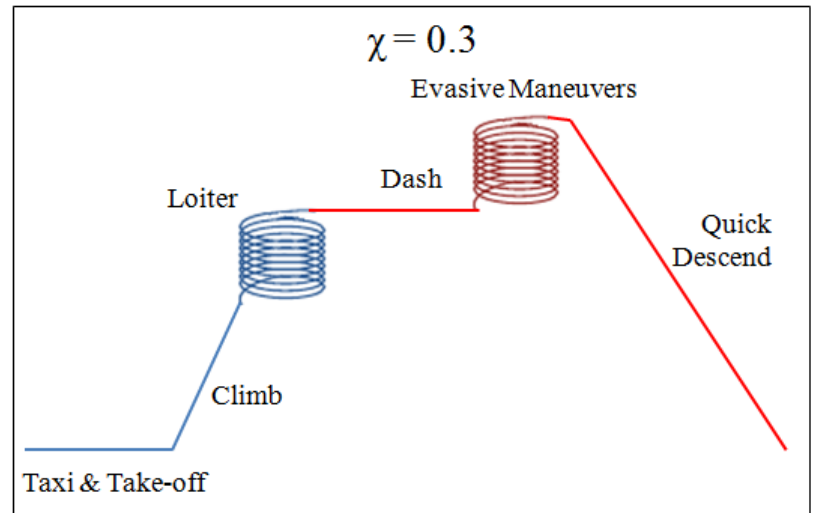
Figure 4. Mission profile of an attack